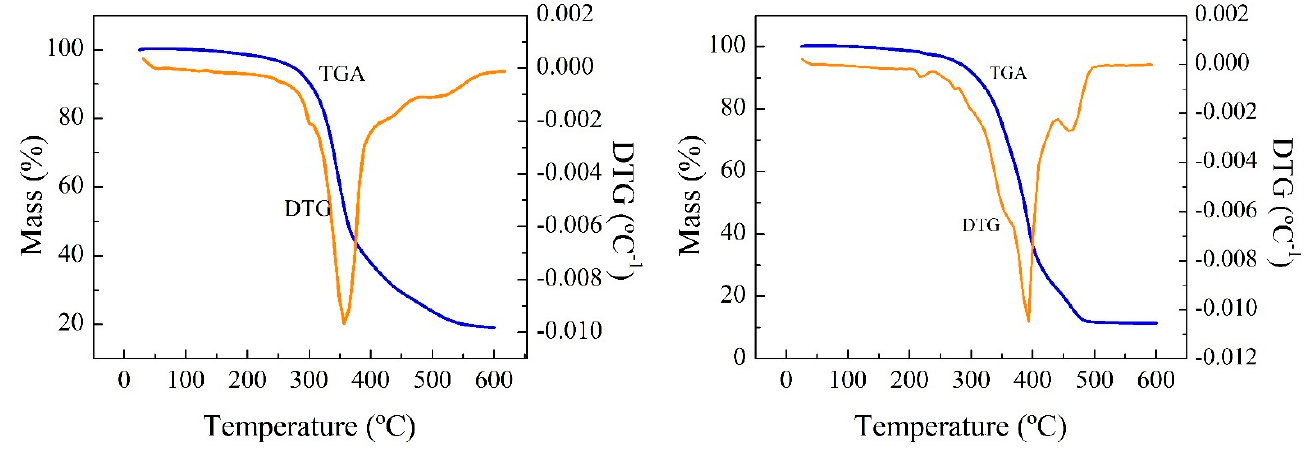
Figure 2. TG (blue) and dTG (orange) curves of the residues RPUF ‐ B and RPUF ‐ C.